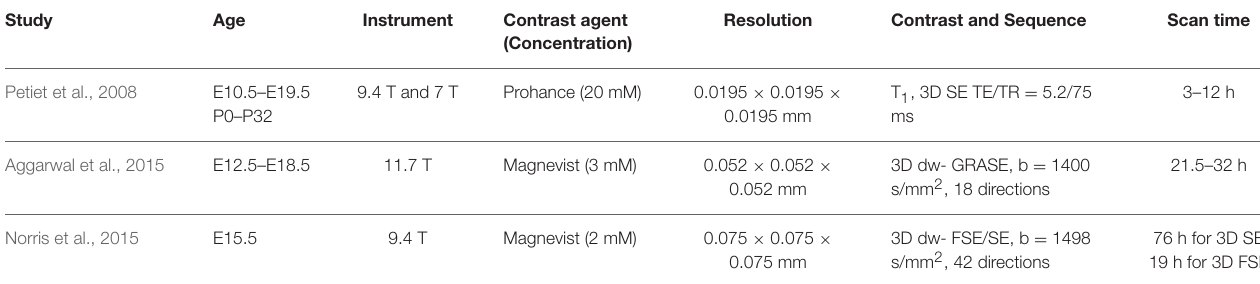
TABLE 1 | Imaging parameters of selected reports on ex vivo MRI of the embryonic and neonatal mouse brain. Study Age Instrument Contrast agent Resolution Contrast and Sequence Scan (Concentration)